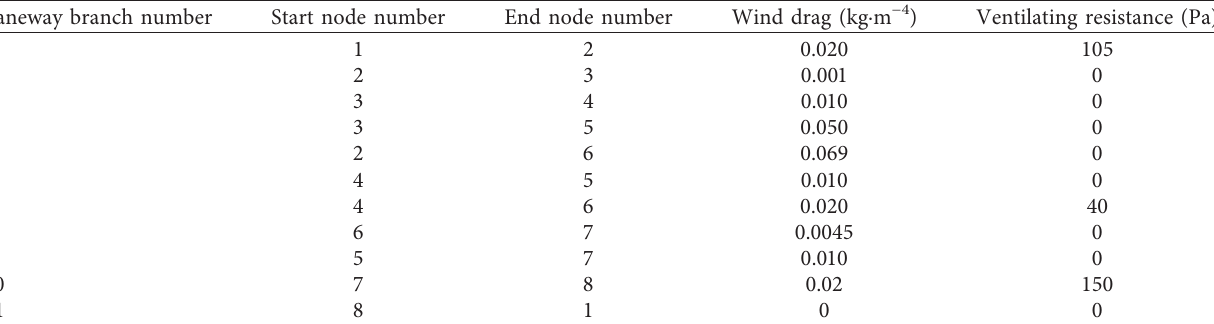
Figure 4: Mine ventilation network diagram (a) and its minimum spanning tree (b). Table 4: Basic ventilation parameters for the